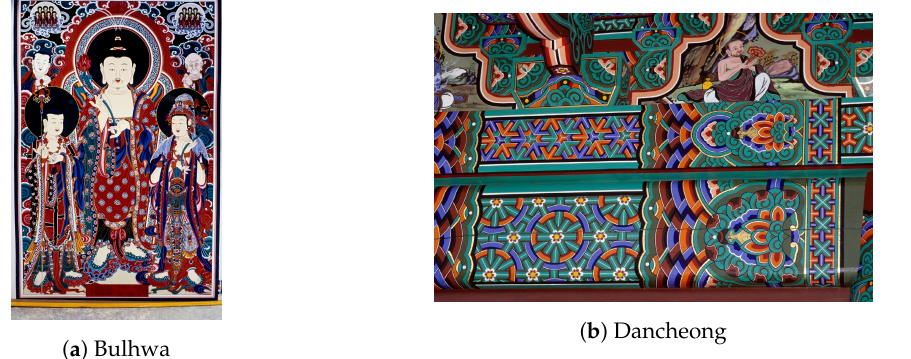
Figure 1. Two important branches in traditional Korean painting. Bulhwa means Buddhist painting which depicts Buddhas, bodhisattvas, and other relevant entities. Dancheong is traditional decorative coloring on wooden